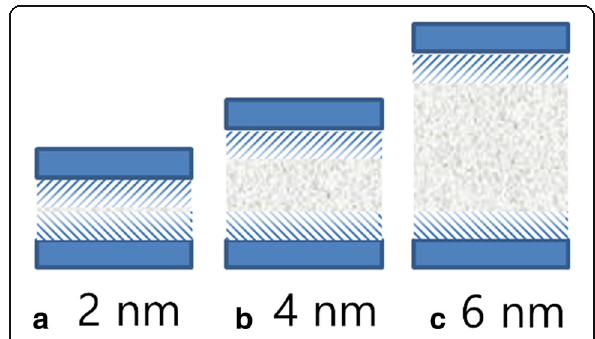
Fig. 6 a , b , c Schematic of the range of adsorption between oil and